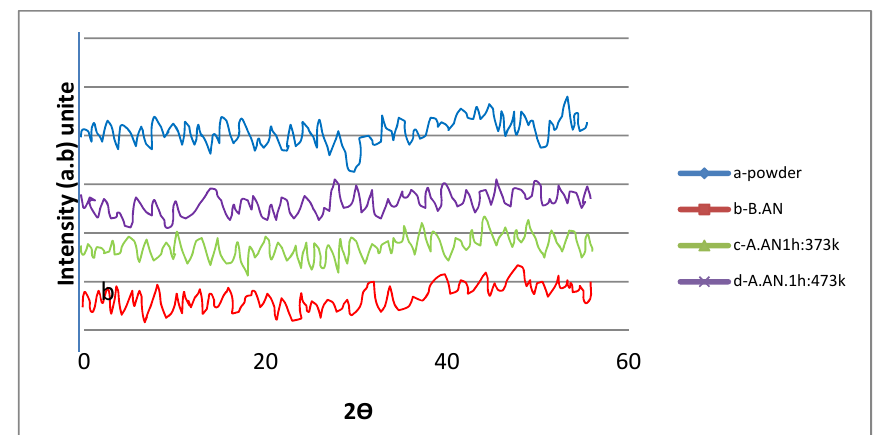
Fig. 3: X-ray diffraction of Ge